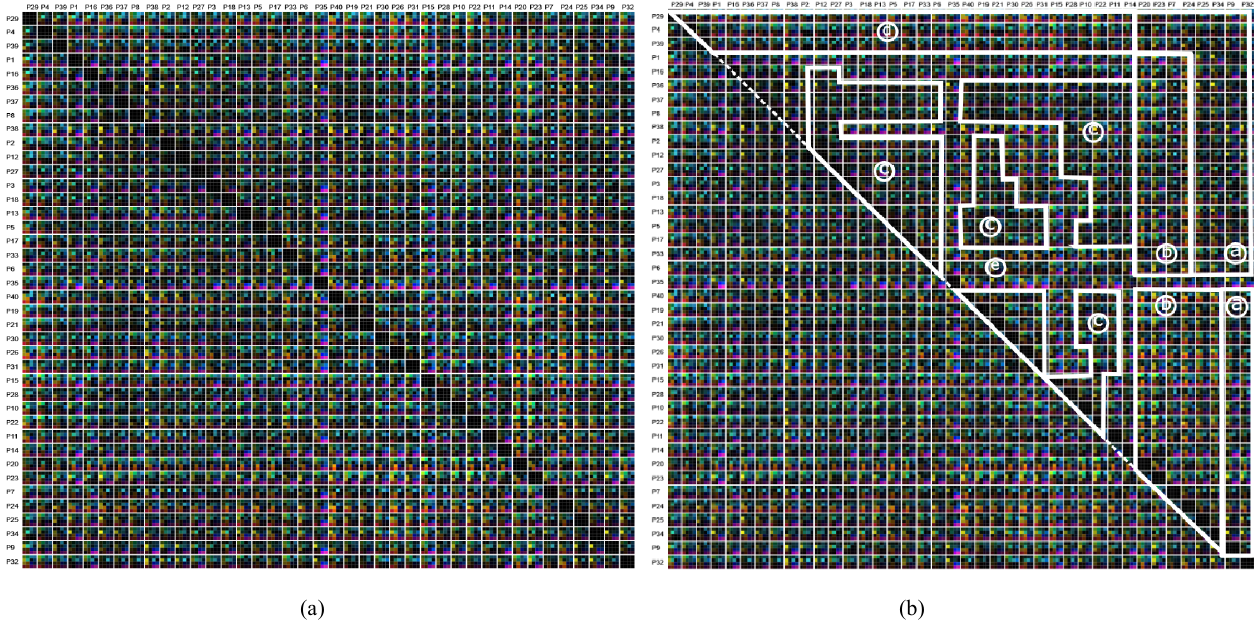
Figure 14 . Similarity matrices including all participants. All 16 similarity metrics are depicted by color. The order of the participants was changed according the result of the clustering based on the new combined metric (skewness in x- and y- direction with a weight of 0.3; kurtosis in x- and y- direction with a weight of 0.7). By visual inspection, six clusters emerge ((a)—(e)), highlighted by white